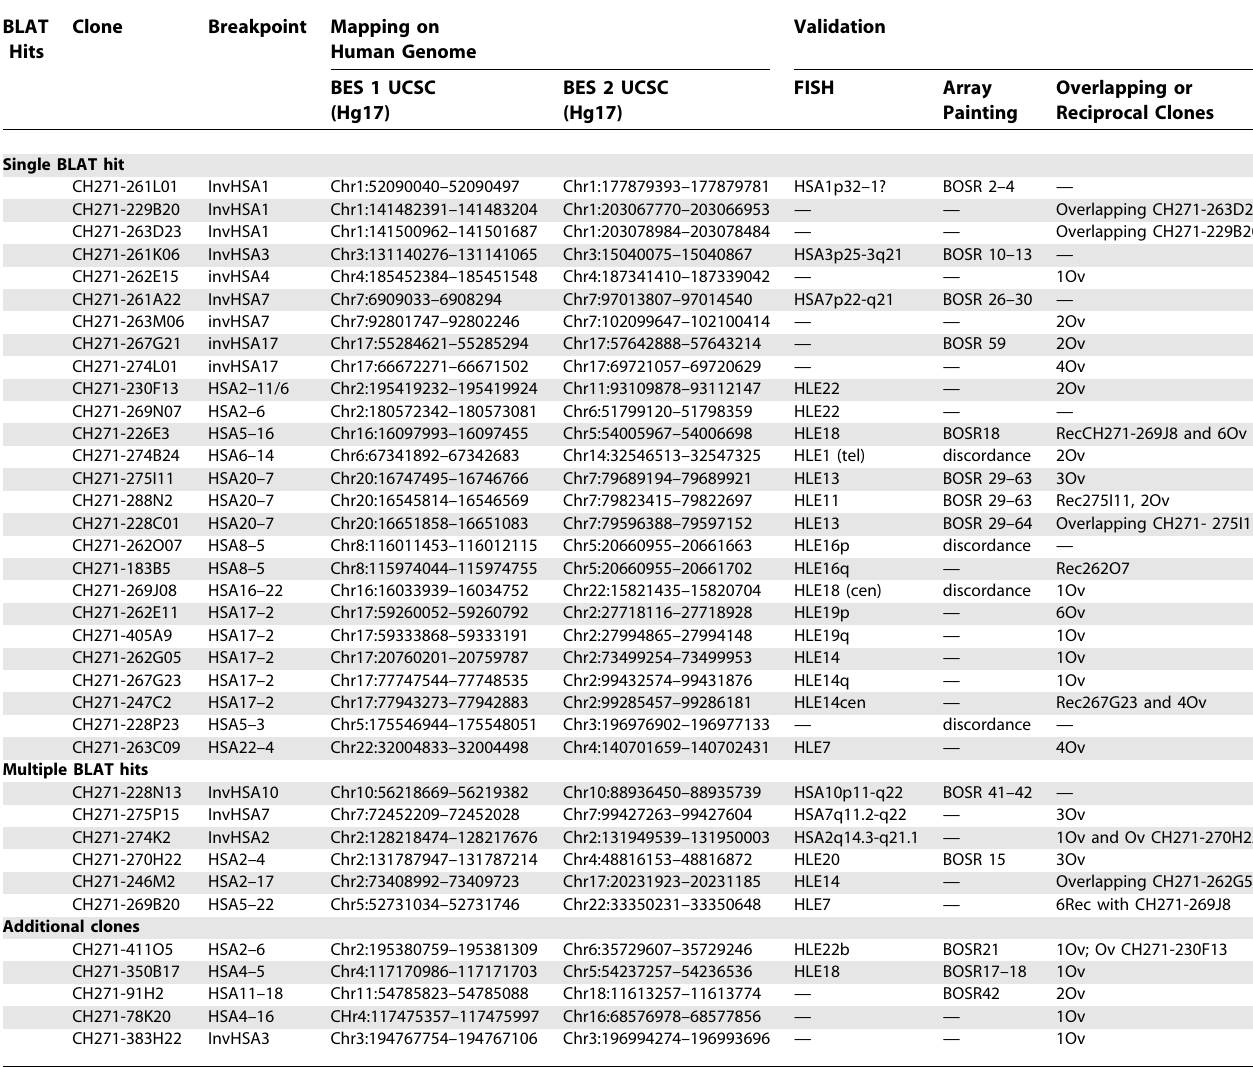
Table 3. Gibbon BAC Clones Spanning Breakpoints Identified by Mapping End